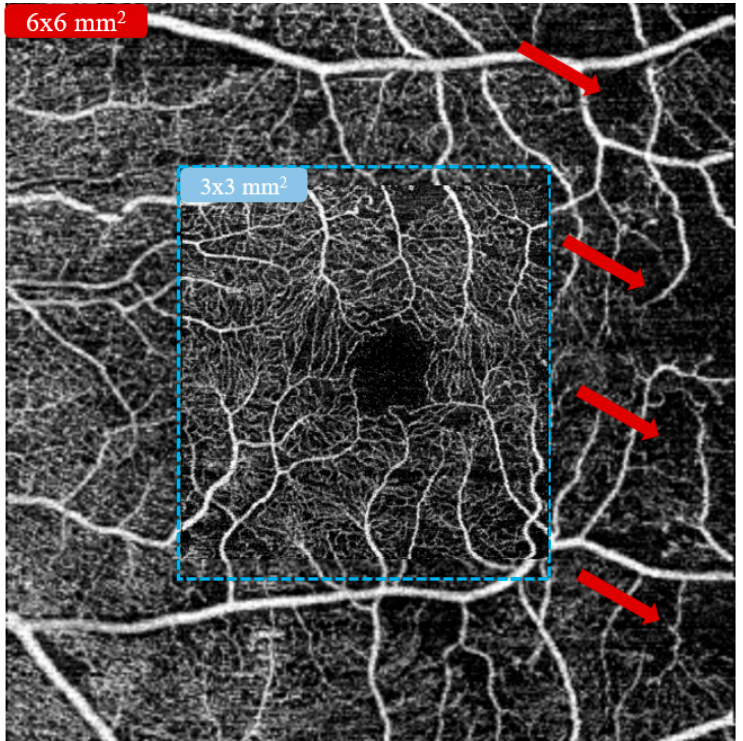
Figure 3. An example illustrating that the 6 × 6 mm 2 optical coherence tomography angiography (OCT-A) scanning protocol with larger field of view can detect non-perfusion area (red arrow) out- side of the standard centralized 3 × 3 mm 2 scanning protocol.